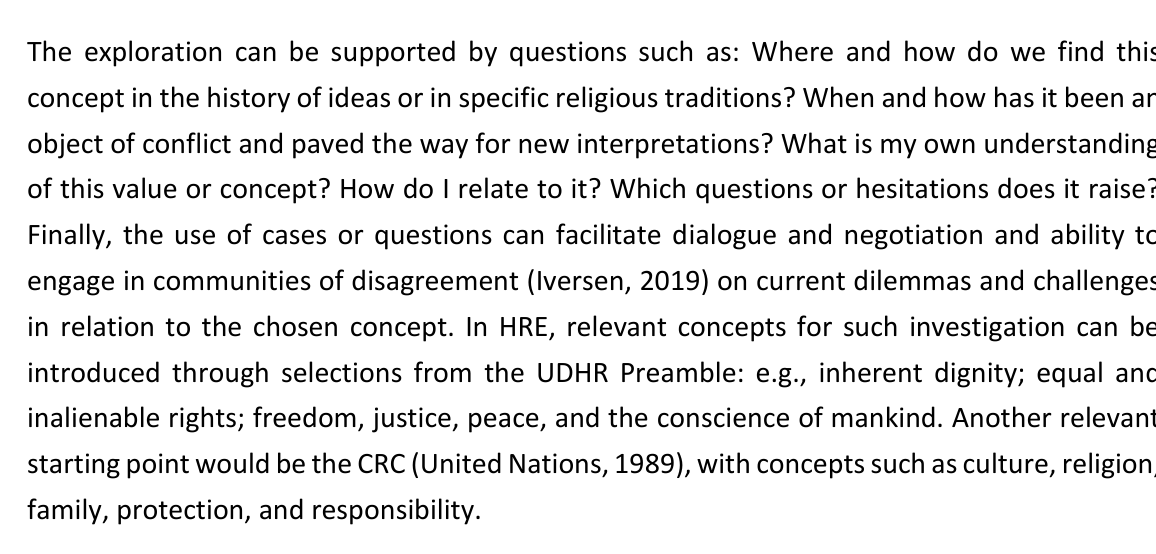
Figure 1: (Sigurdsson,